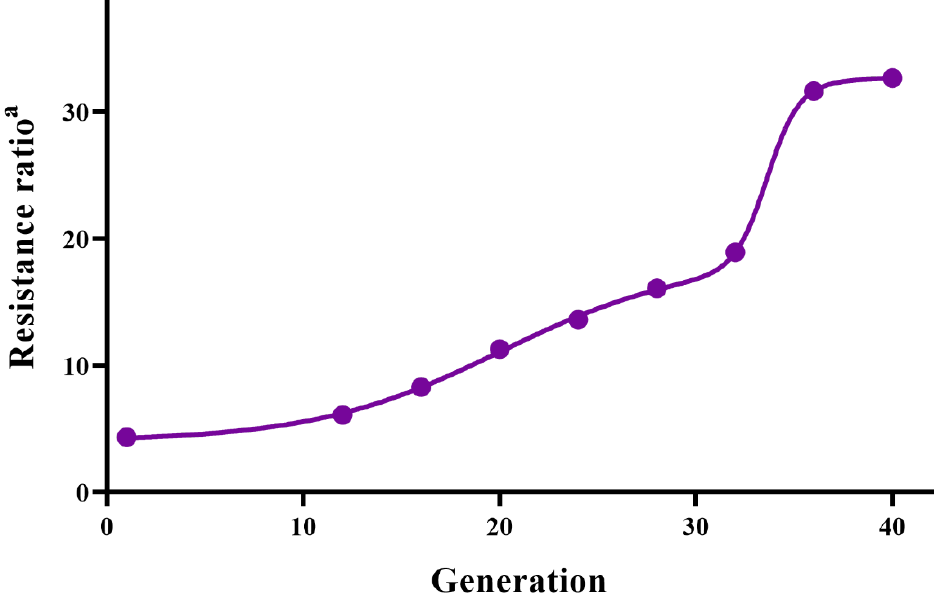
Figure 1. Results of resistance selection to malathion in S. miscanthi . a Resistance ratio = LC 50 of the MRS strain/LC 50 of the MSS strain. Table 1. Estimation of realized heritability ( h 2 ) of malathion resistance in S. miscanthi .